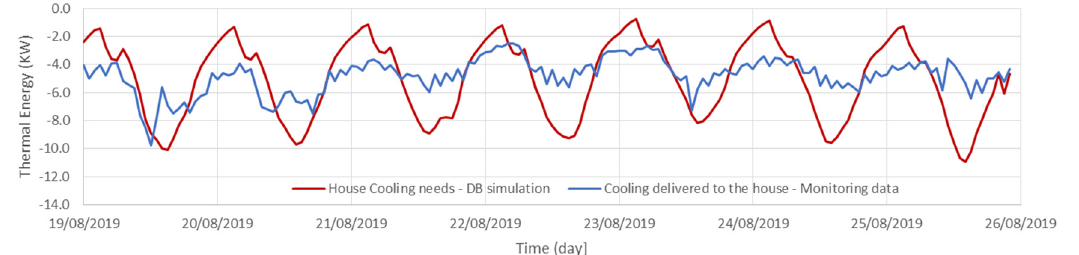
Figure 10. Cooling delivered to the house by the TESSe2b system and cooling needs obtained by the DB simulations.